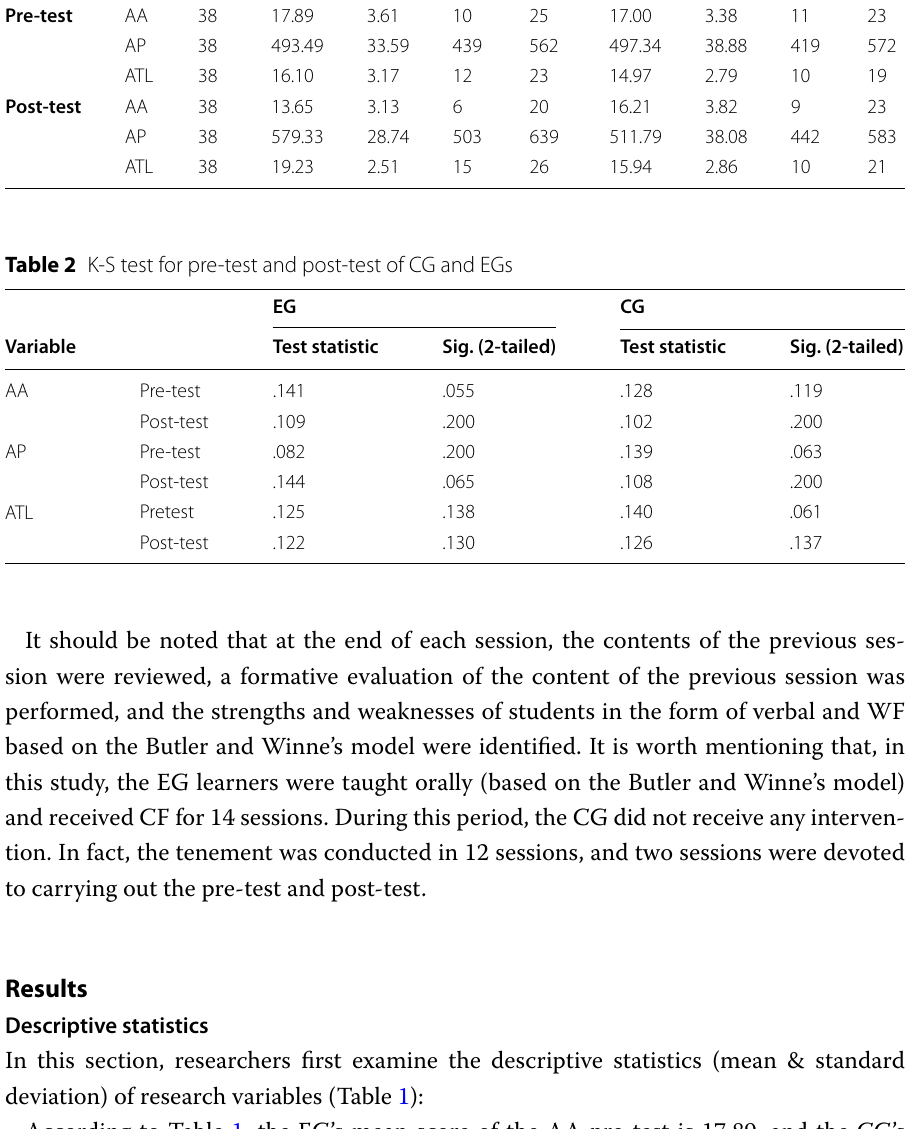
Table 1 Central indicators and dispersion of pre‑test and post‑test in CG and EG EG CG N M SD Min